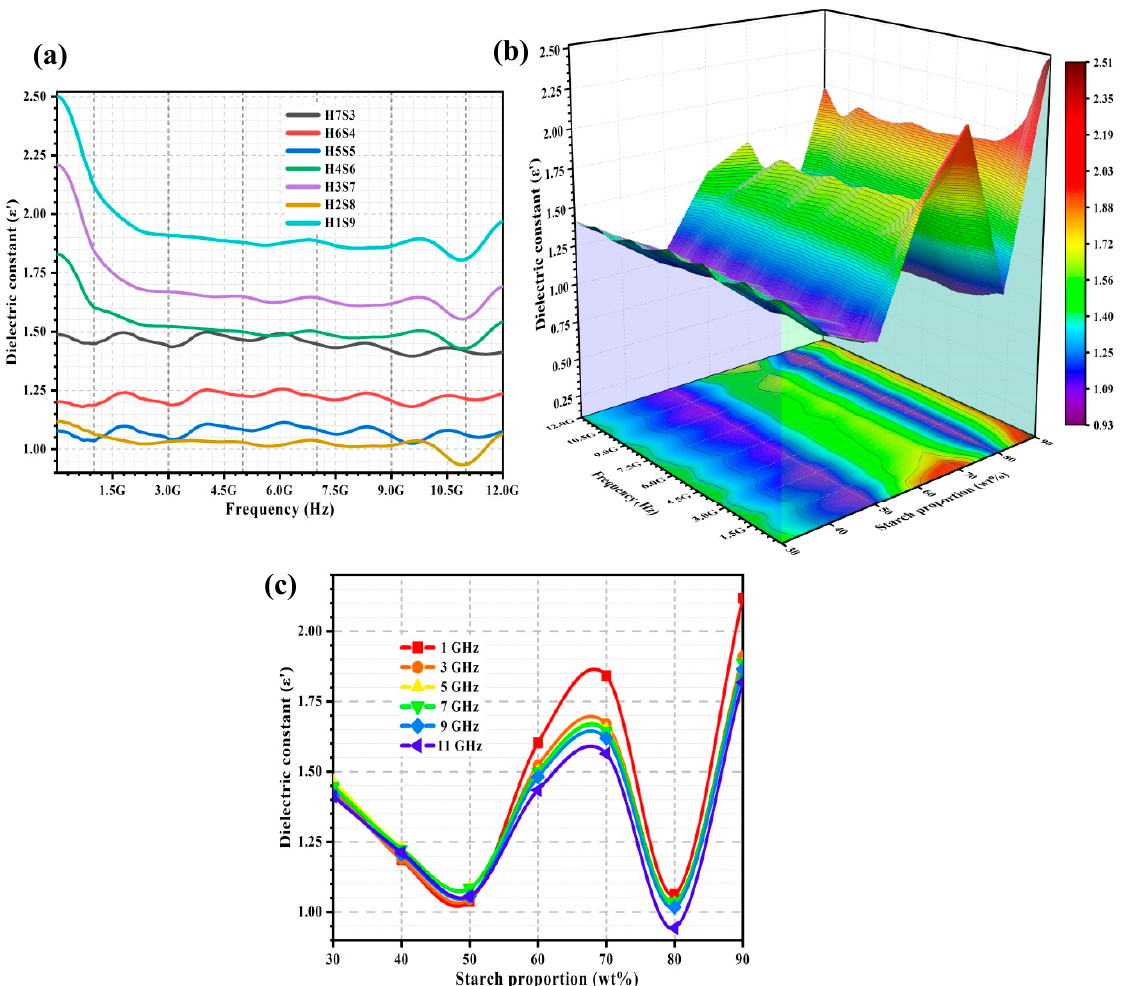
Figure 3. ε (cid:48) ( a ) of the porous nHA/S composites, 3D representation of ε (cid:48) of the porous nHA/S Figure 3. ε′ ( a ) of the porous nHA/S composites, 3D representation of ε′ of the porous nHA/S composites ( b ), and ε (cid:48) curves of the porous nHA/S composites at various selected frequencies ( c composites ( b ), and ε′ curves of the porous nHA/S composites at various selected frequencies ( c ).